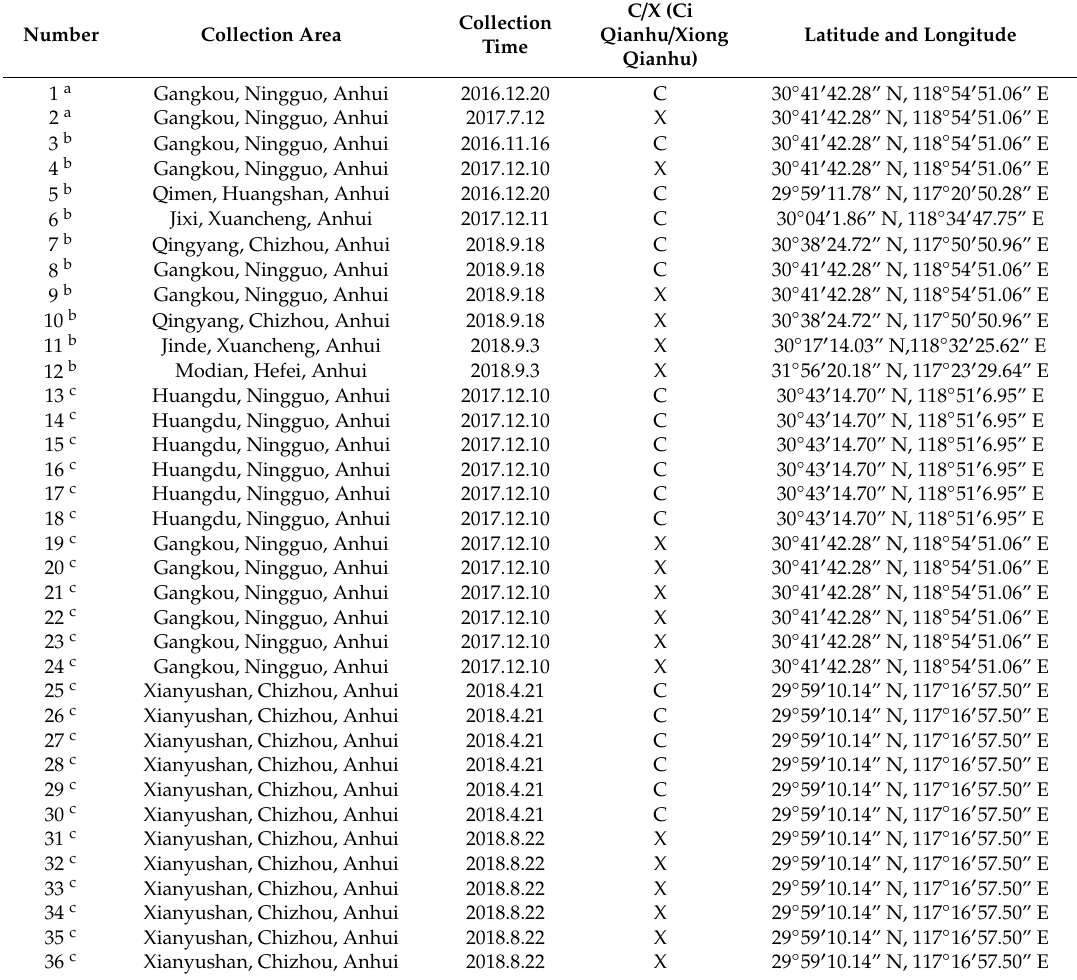
a samples were used for Para ffi n section; b samples were used for Qualitative analysis; c samples were used for Quantitative